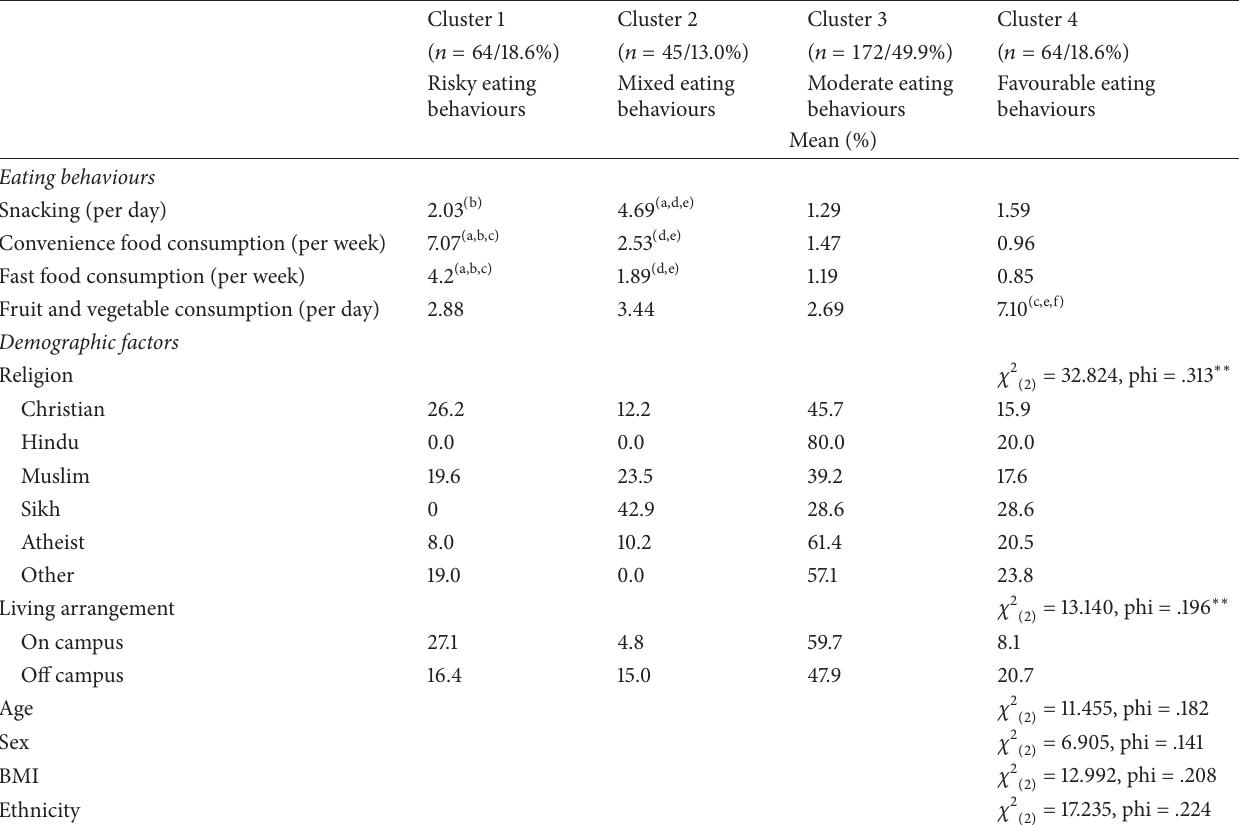
Table 2: Mean scores and percentages for the four clusters of British students at a UK university in